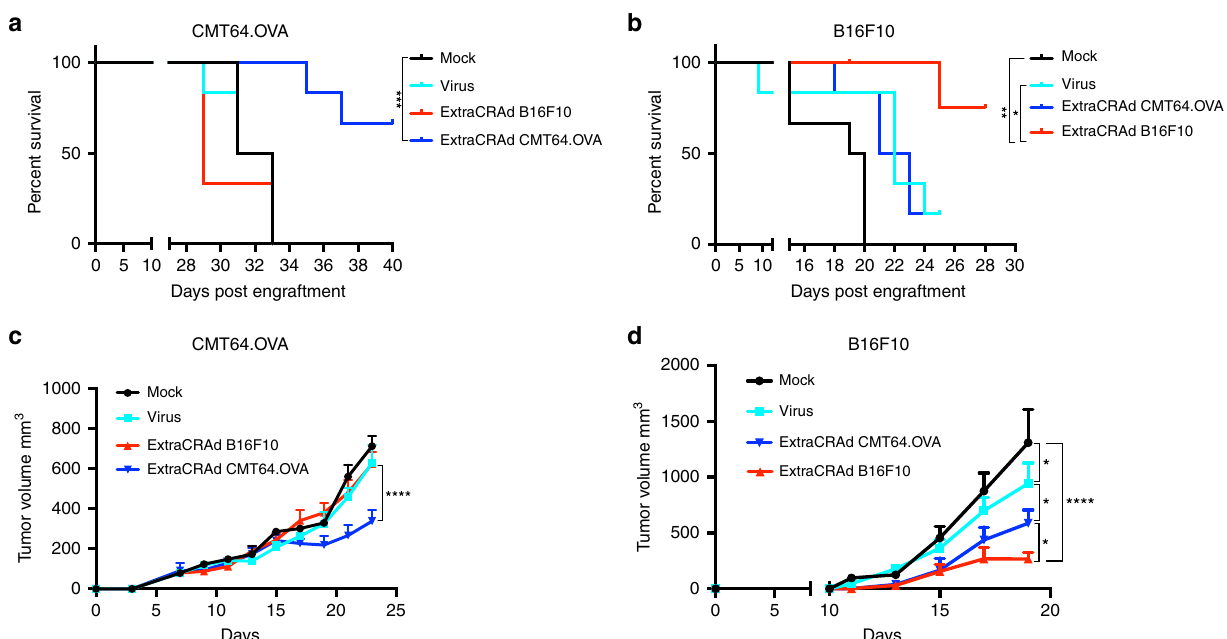
Fig. 6 Ef fi cacy of ExtraCRAd in a pre-immunization set-up in melanoma and lung cancer models. a Long-term overall survival of C57BL/6 mice injected with 7 × 10 6 CMT64.OVA subcutaneously in the fl ank. b Long-term overall survival of C57BL/6 mice injected with 1 × 10 5 B16.F10 cells subcutaneously in the fl ank. In both the models, animals were removed from the survival curve upon sacri fi ce. Mice dead for causes not imputable to the tumor growth or mice still alive at the completion of the study were censored in the survival curves. The data were analyzed with log-rank (Mantel – Cox) curve comparison. The levels of signi fi cance were set at * p < 0.05, ** p < 0.01, and *** p < 0.001. Mean tumor growth curve (mm 3 ) in c the CMT64.OVA model and d the B16. F10 model. The data are presented as mean ± SEM ( n = 6). The data were analyzed with two-way ANOVA followed by Tukey ’ s ( c ) and Fisher ’ s ( d ) post test. The levels of signi fi cance were set at probabilities of * p < 0.05 and **** p < 0.0001. The error bars represent